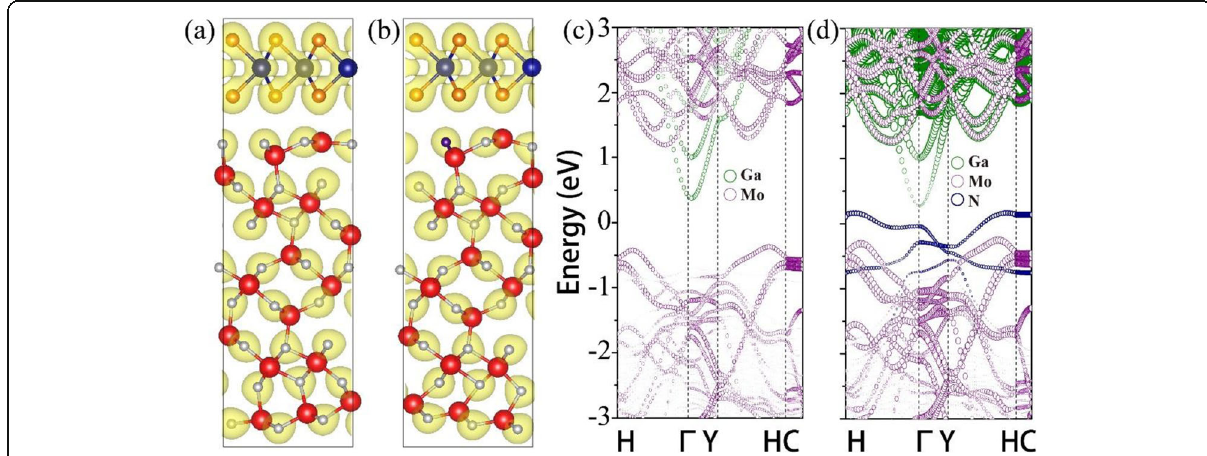
Fig. 6 Atomic structure and charge-density distributions of β -Ga 2 O 3 -MoS 2 stacked heterostructures a without and b with nitrogen dopants in a 4 × 4 × 1 supercell from a side view. Ga (O) atoms are in red (gray) and Mo (S) atoms in blue (orange). Band structures of MoS 2 / β -Ga 2 O 3 heterostructures c without and d with nitrogen